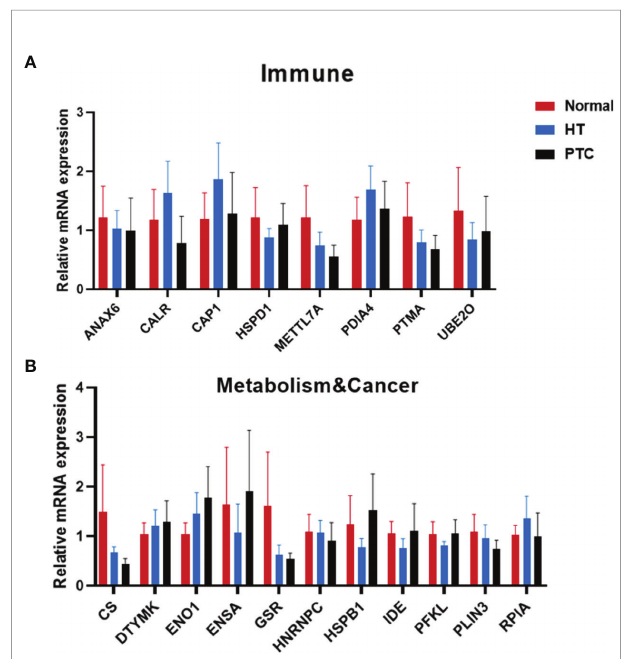
FIGURE 3 | Transcriptional changes with functional groups relevant to the immune system and metabolism&cancer in thyroid tissue. Molecular changes in transcription levels between Hashimoto ’ s thyroiditis (HT) and Control relevant to the immune system (A) and metabolism&cancer (B) were evaluated by semiquantitative PCR [Normal, n = 3; HT, n = 5; papillary thyroid carcinoma (PTC), n = 6]. Error bars show the